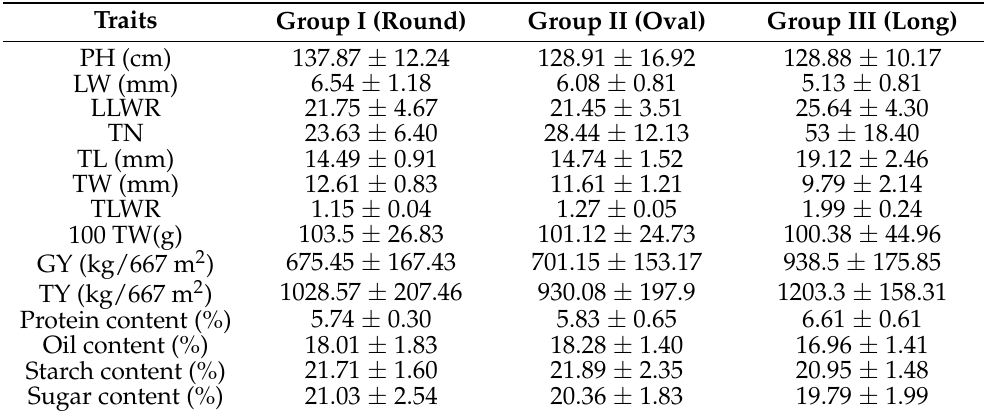
Table 3. ANOVA analysis of the agronomic and biochemical traits in three tiger nut groups with different tuber